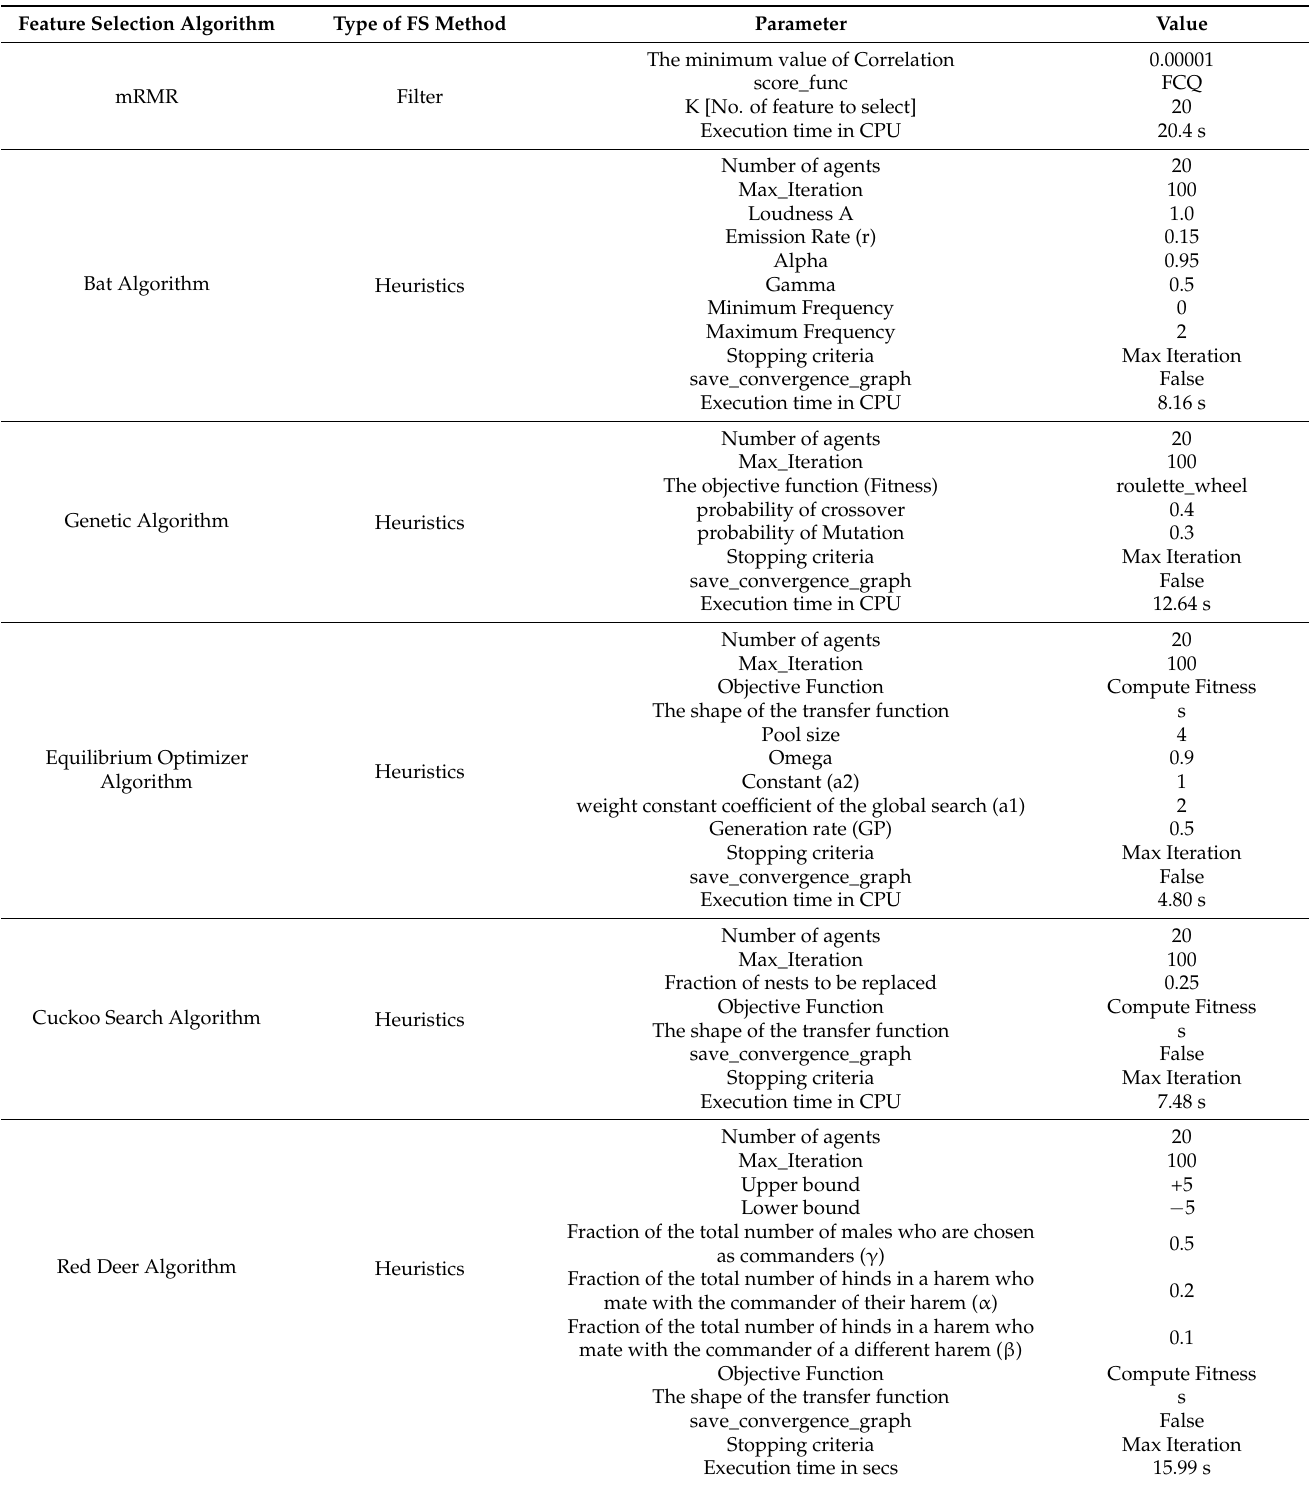
Table 3. Feature selection methods’ parameter